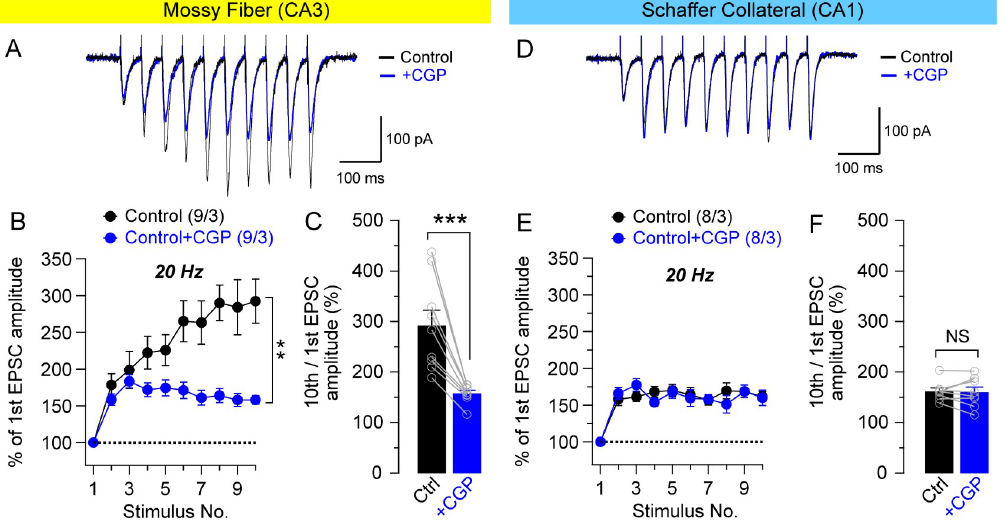
Fig 5. Inhibition of mitochondrial Ca 2+ release selectively reduces synaptic facilitation at MF synapses. ( A ) Representative EPSCs recorded before and after treatment of CGP37157 (20 μ M) on frequency facilitation elicited by 20 Hz stimulus train at MF synapses. Scale bar: 100 ms, 100 pA. ( B ) Inhibition of mitochondrial Ca 2+ release by CGP37157 significantly reduces synaptic facilitation at MF synapses (F 1, 16 = 10.23, p = 0.0056; two-way ANOVA). ( C ) Summary graph of the mean magnitude of the 10th stimulus train of frequency facilitation at MF synapses. The inhibition of mitochondrial Ca 2+ release by CGP37157 significantly reduces the mean magnitude (157.9 ± 6.0%), relative to the control (292.4 ± 30.1%, p = 0.0008; paired t -test). ( D ) Representative EPSCs recorded before and after treatment of CGP37157 (20 μ M) on frequency facilitation elicited by 20 Hz stimulus train at SC synapses. Scale bar: 100 ms, 100 pA. ( E ) Inhibition of mitochondrial Ca 2+ release by CGP37157 has no effect on synaptic facilitation at SC synapses. ( F ) Summary graph of the mean magnitude of the 10th stimulus train of frequency facilitation at SC synapses. Inhibition of mitochondrial Ca 2+ release by CGP37157 does not significantly reduce the mean magnitude (159.9 ± 10.4%), relative to the control (161.7 ± 6.8%, p = 0.776; paired t -test). All data represent mean ± SEM ( �� p < 0.01, ��� p < 0.001, NS: not significant; two-way ANOVA for panels B and E, Student’s t - test for panels C and F). The value in parentheses indicates the number of hippocampal neurons (left) and the number of mice (right) used in each experiment.